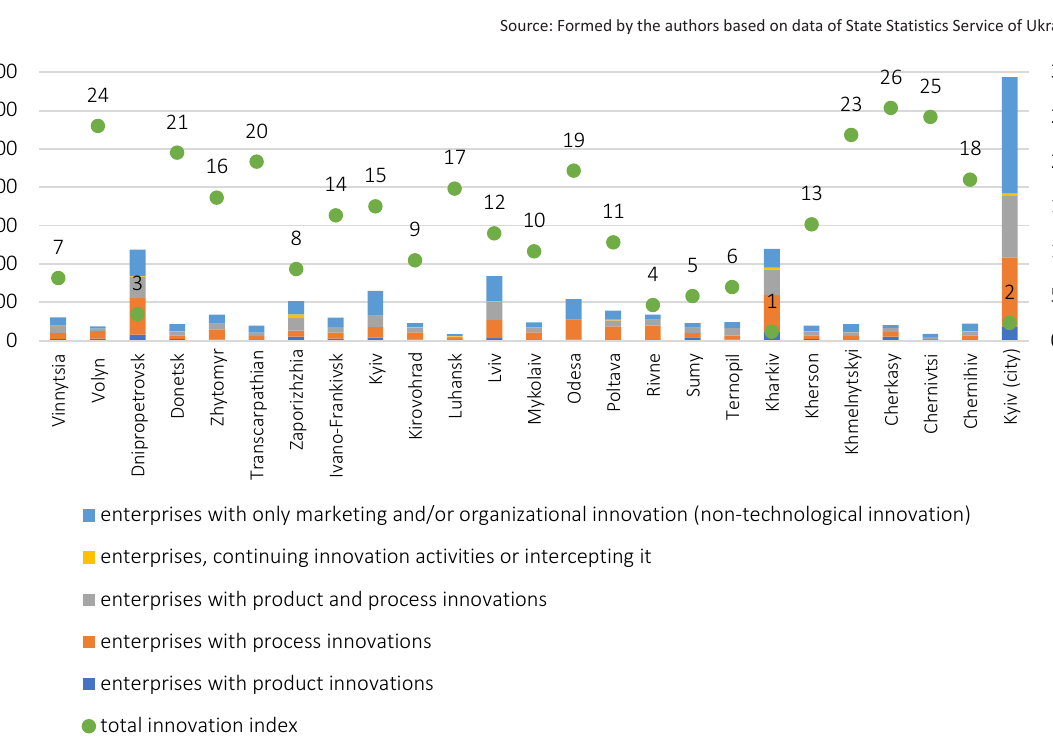
Figure 6. Regional distribution of business innovative activity and rate of every region in